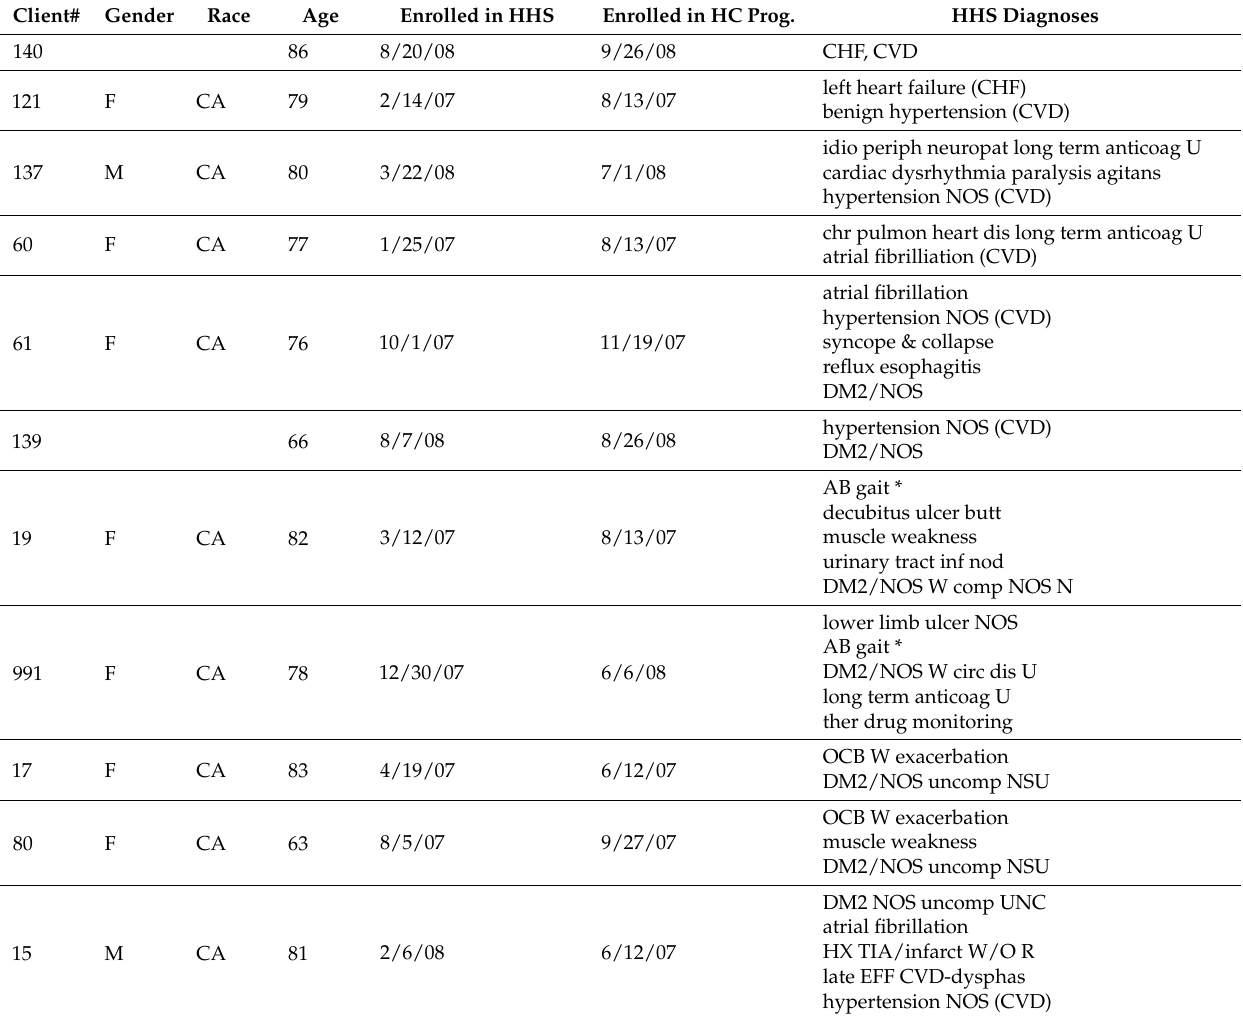
Table 2. Gender, Race, Age, HHS and HC Program Enrollment Dates, HHS Diagnoses of Health Coach Clients with No Emergent Care ( N = 19/33,